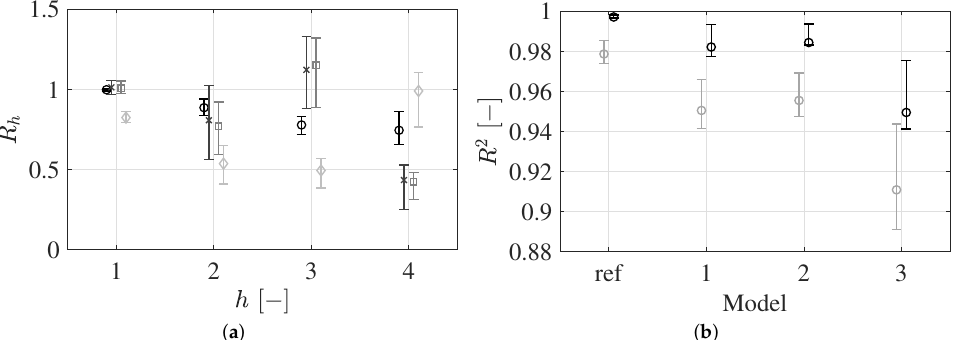
Figure 8. ( a ) R h for the first four harmonics: mean value (symbol: model ref ( ◦ ), model 1 ( × ), model 2 ( (cid:3) ) and model 3 ( ♦ )) and error bar indicating the ( P 25 − P 75 ) interval; ( b ) The coefficients of determination for the time domain ( R 2 , gray) and the frequency domain ( R 2 , black) for the different t f single-step load models.